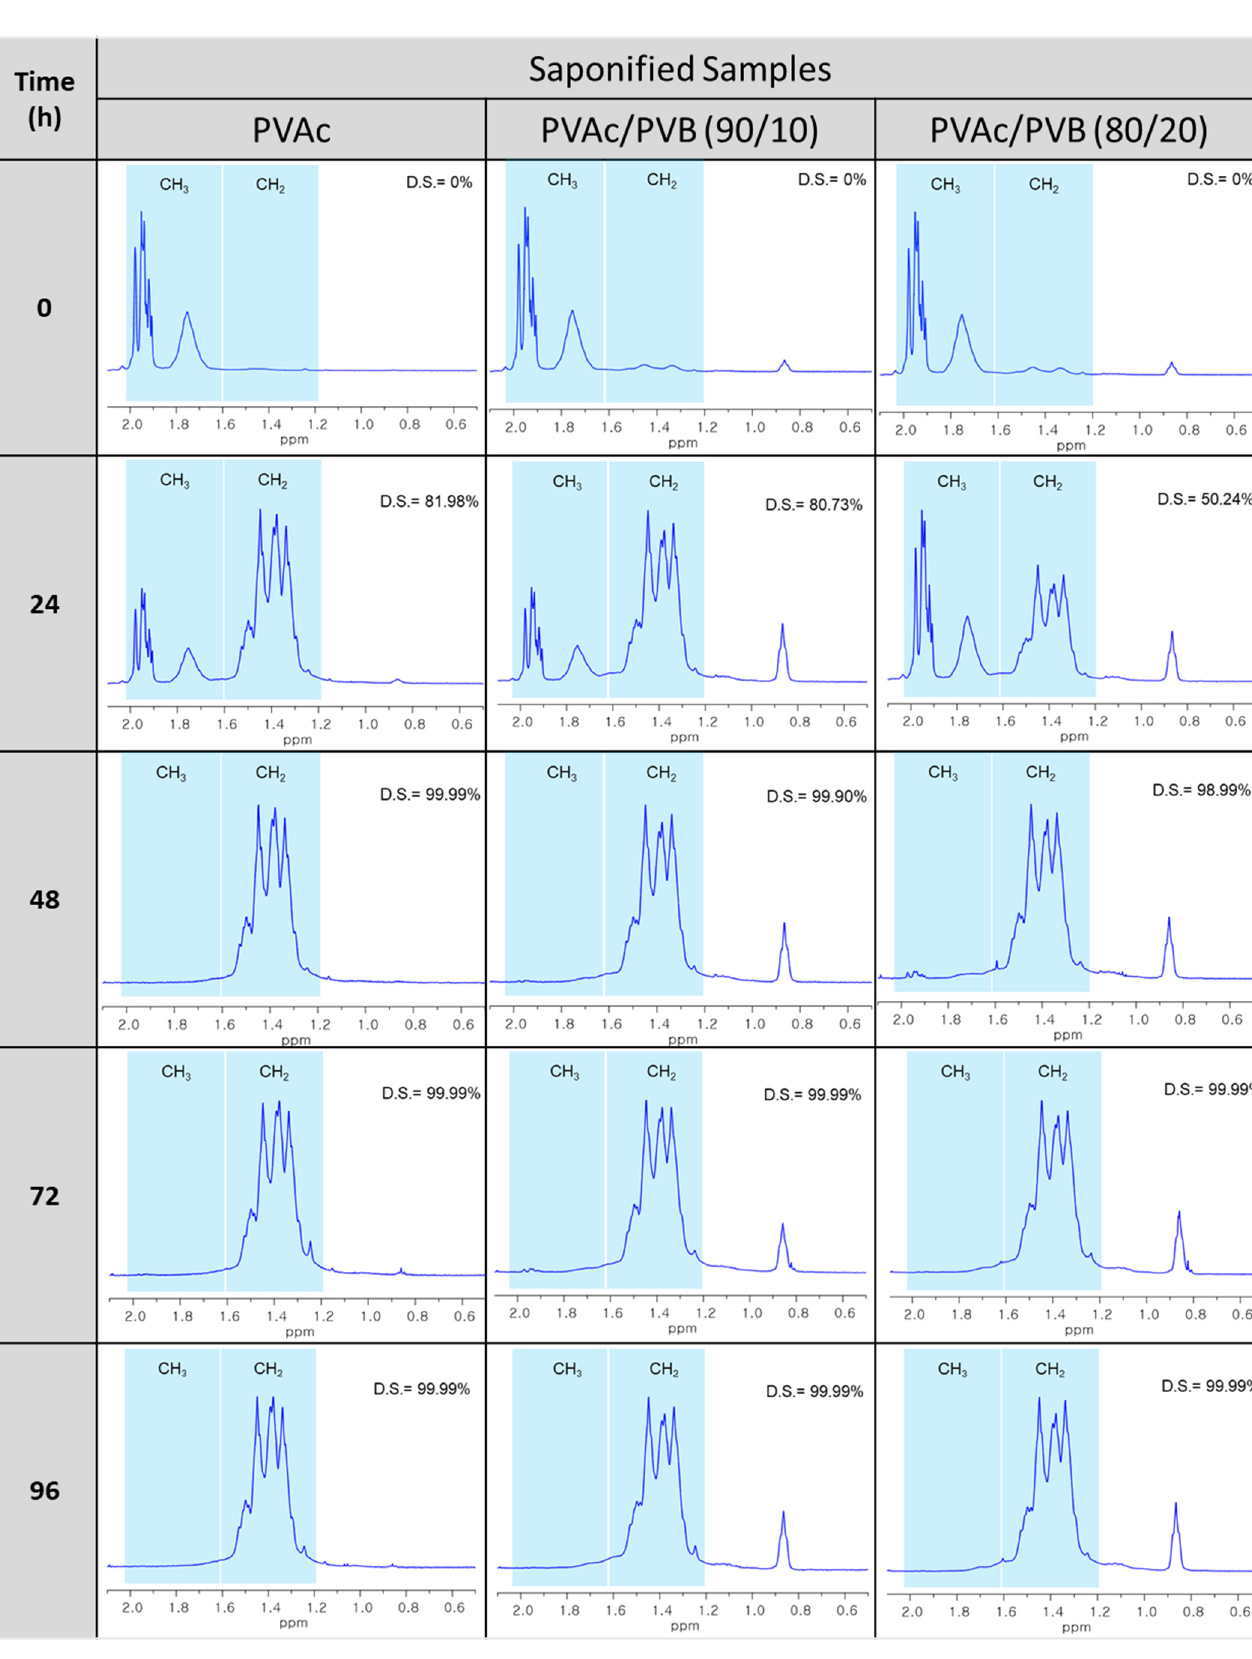
Figure 5. 1 H-NMR spectra of saponified PVAc, PVAc/PVB 90/10, and PVAc/PVB 80/20 films at a saponification temperature of 50 °C and various saponification times (0–96 h).